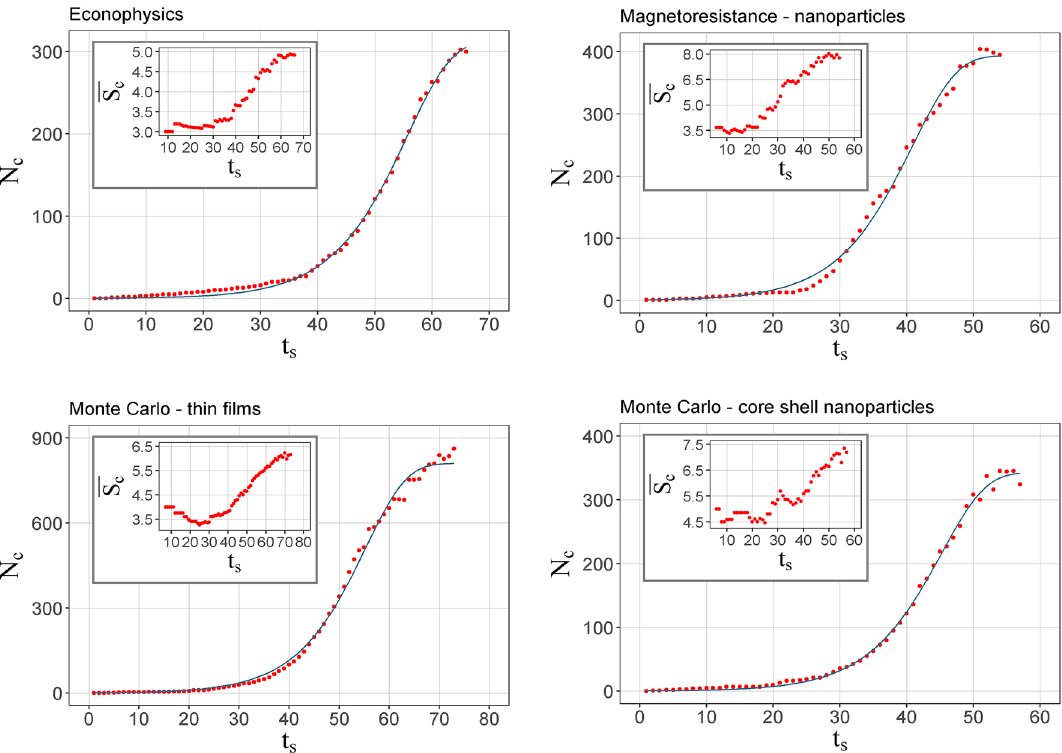
Figure 6. Number of communities as a function of time for the co-authorship networks. The inserted figures correspond to the temporal evolution of the average size of the community,